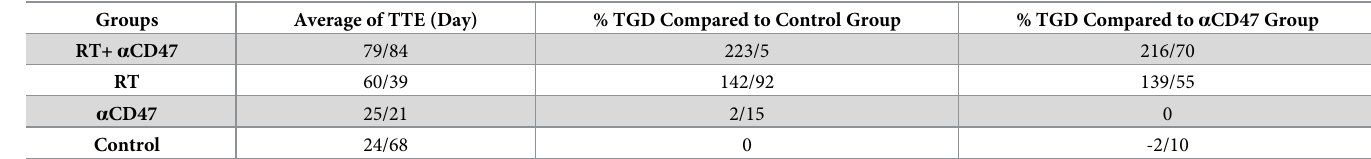
Table 1. The time to endpoint (TTE) and tumor growth delay (%TGD) between the combined RT and α CD47, RT, α CD47, and control groups were calculated.